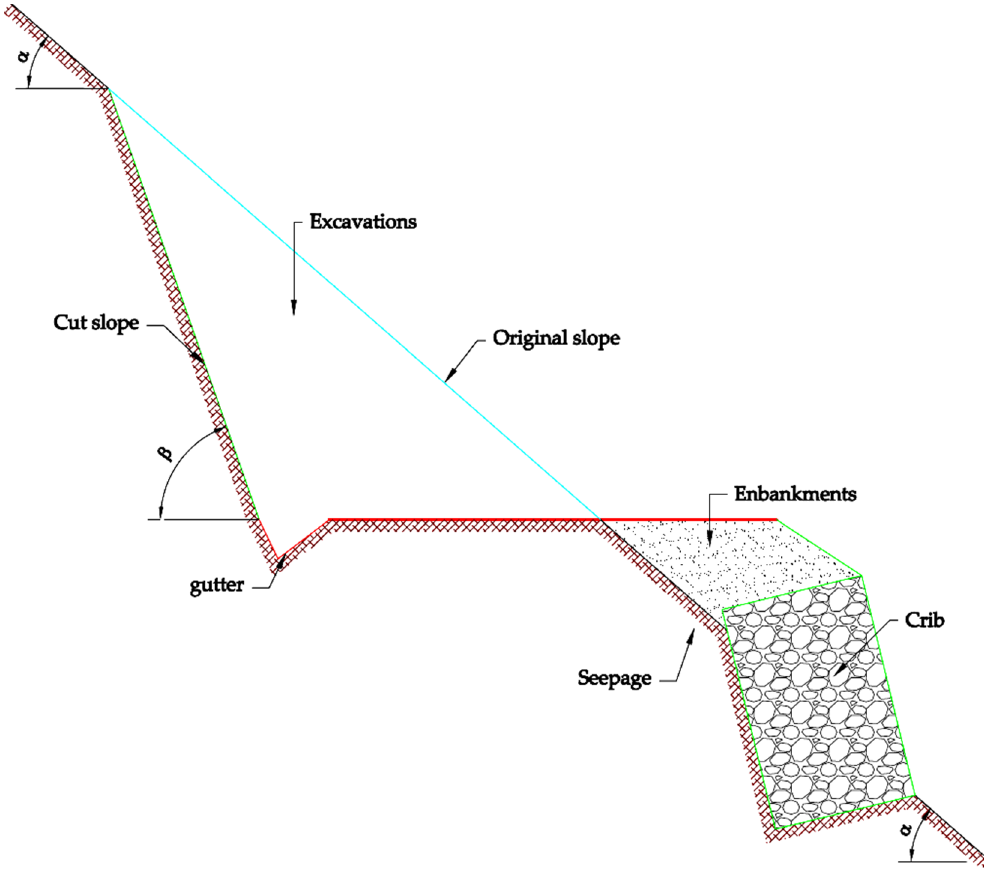
Figure 17. Reduction in excavation made possible on a steep slope by the use of cribbing.